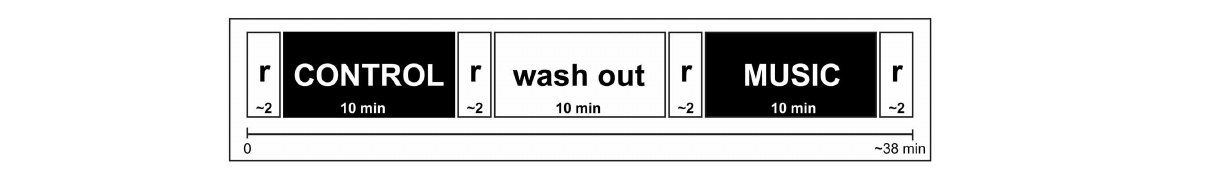
FIGURE 1 | Paradigm to study music-induced analgesia. The participants listened to both conditions in between a washout period, with 2min rests. r, Rest condition.